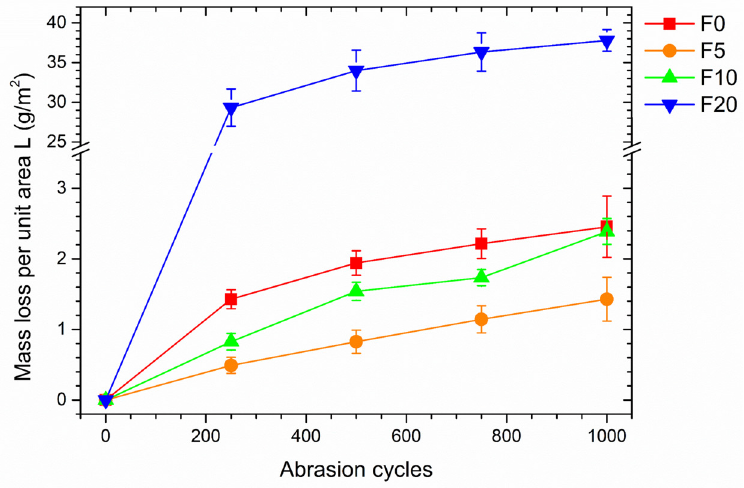
Figure 12. Loss in coatings mass per unit area, as a function of the number of abrasion cycles.